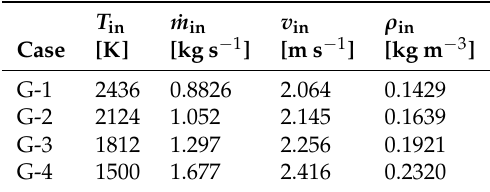
Table 1. Conditions simulated with the simplified fire model (cases G-1 to G-4), run with Fire Dynamics Simulator (FDS) and FLUENT. T in ˙ m in v in ρ in